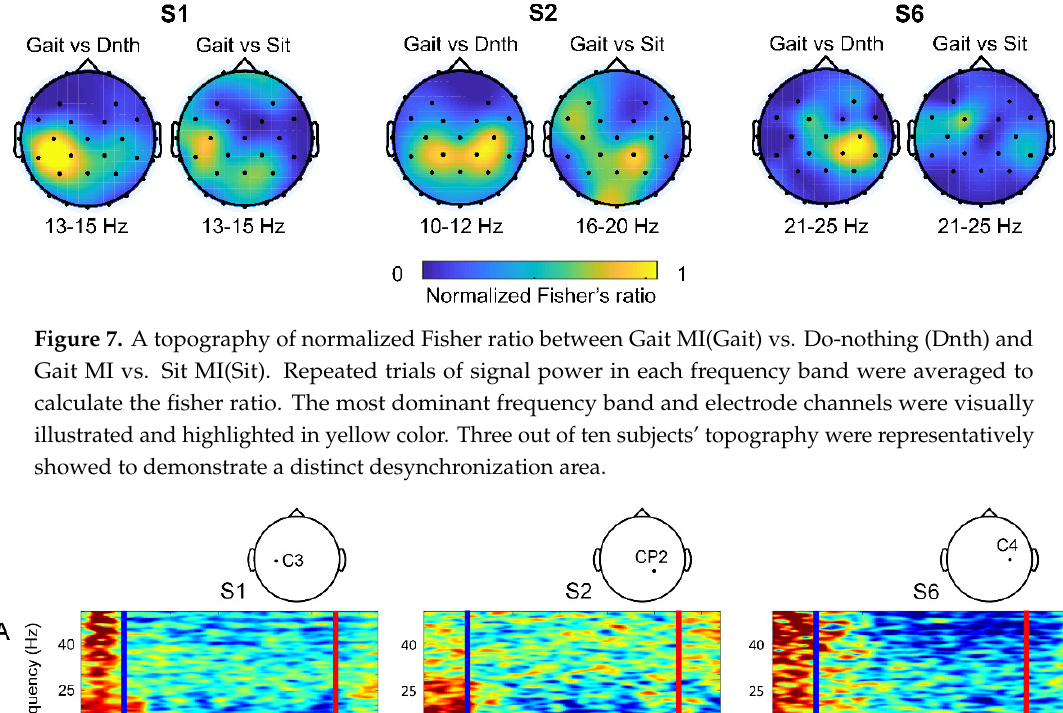
Table 2. Comparison of operating time between the development hybrid BCI controller and the smartwatch controller.